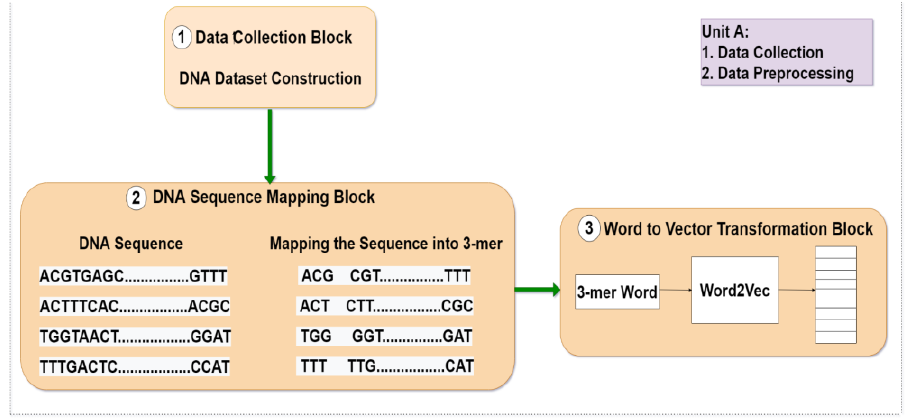
Figure 1. ( a ) (Unit A) Dataset contraction, feature representation, and distributed feature representation block. Table 3. Training parameters used in word2vec.